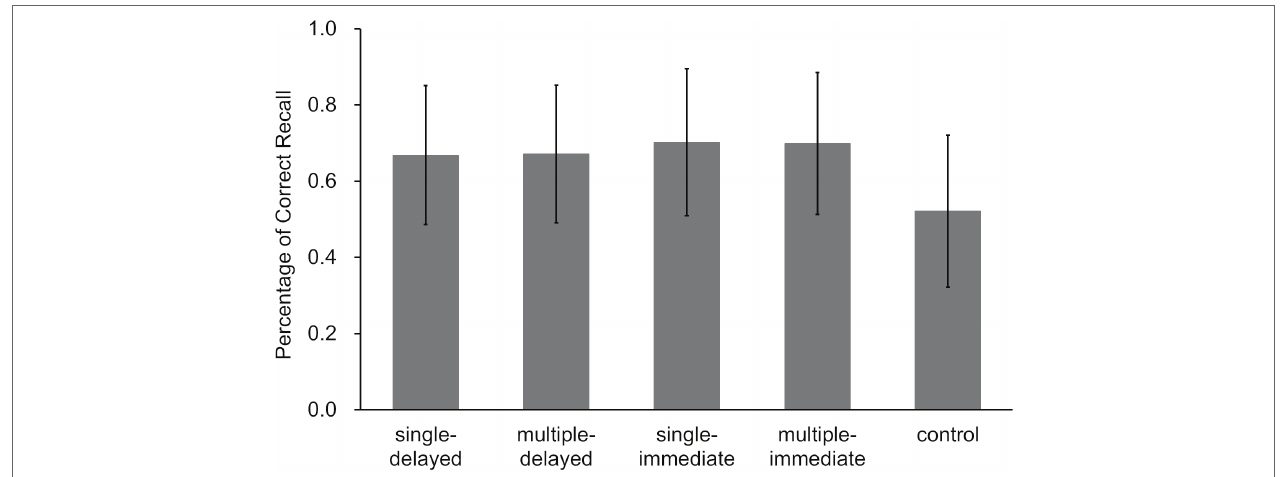
FIGURE 7 | Correct answer rates on the final tests for each learning condition in Experiment 3a (error bars represent SD